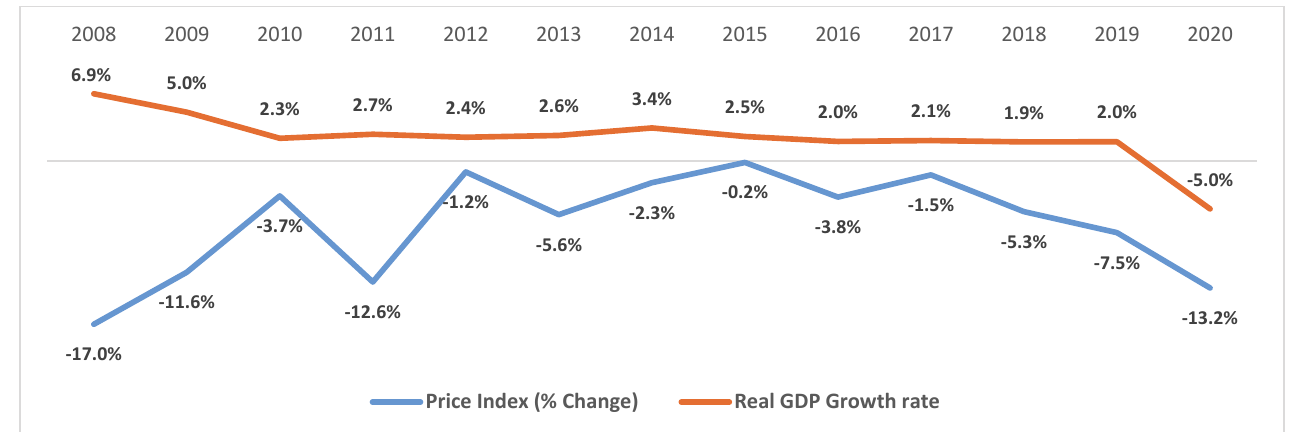
Fig. 2. Real GDP Growth Rate Versus ASE's Price Index